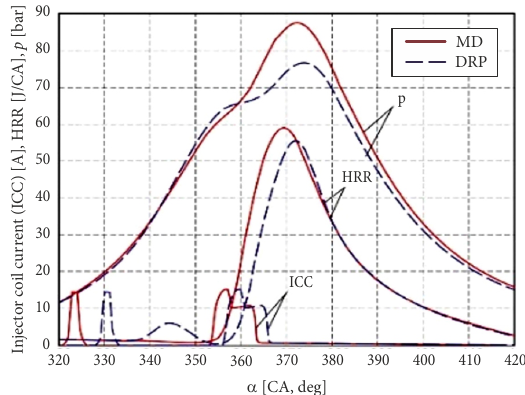
Figure 12. Injection current vs CA for MD and